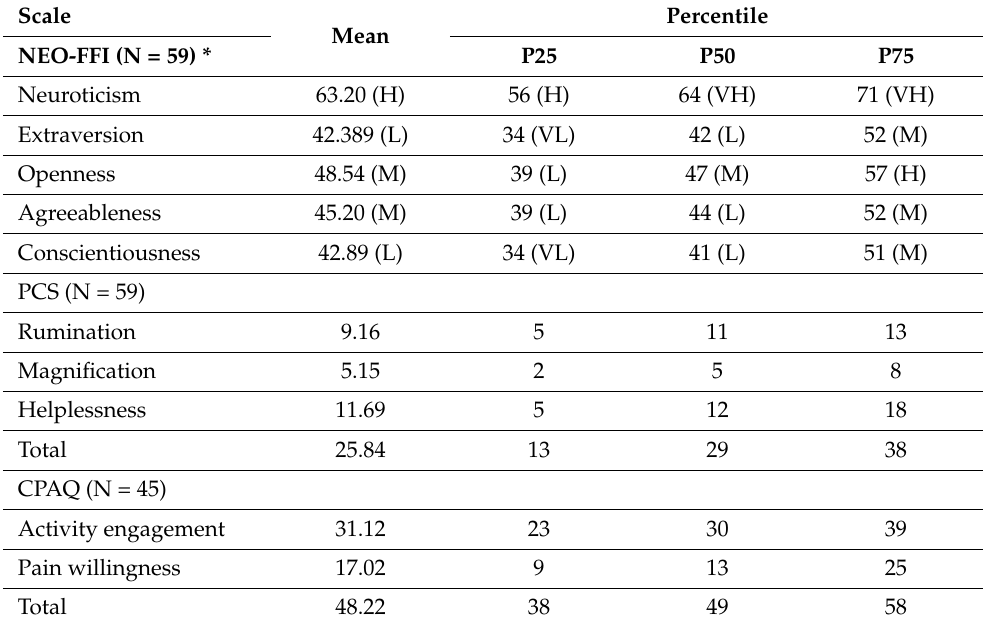
Table 2. Means and percentiles of NEO-FFI, PCS and CPAQ scales.